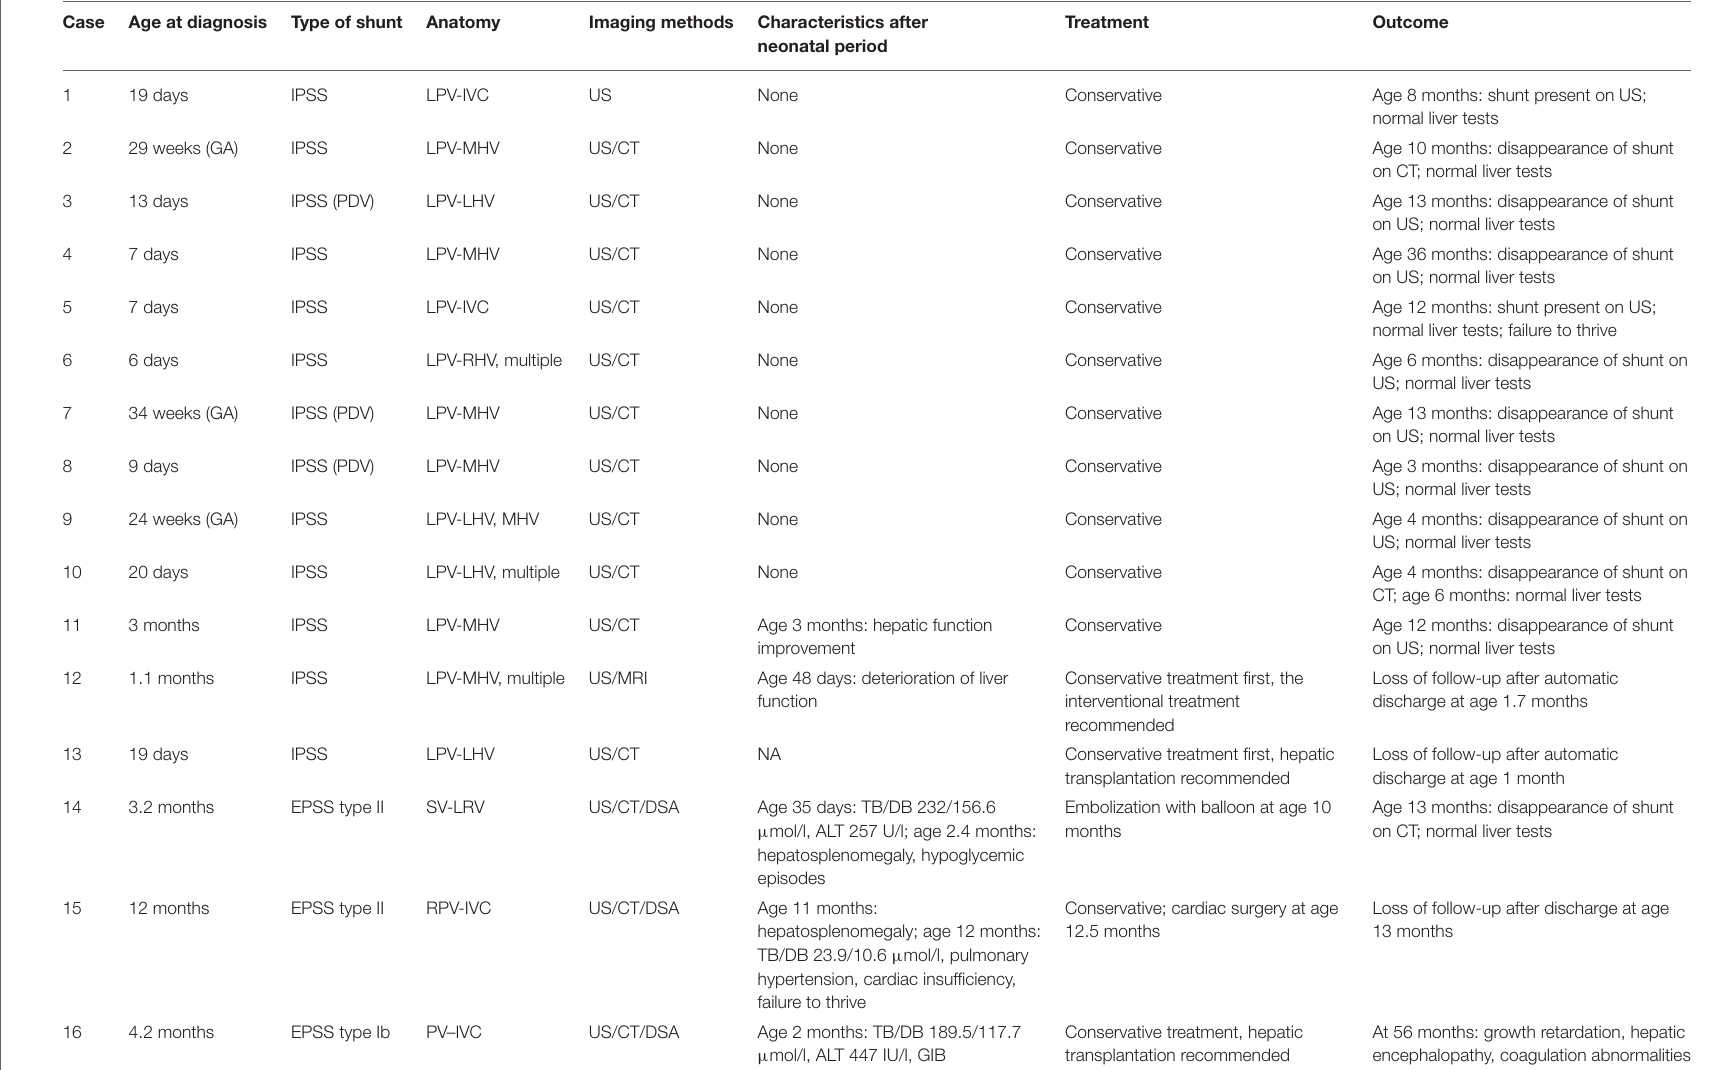
ALT, alanine aminotransferase; CPSS, congenital portosystemic shunts; CT, computerized tomography; DB, direct bilirubin; Dx, diagnosis; DSA, digital subtraction angiography; EPSS, extrahepatic portosystemic shunts; GA, gestational age; GIB, gastrointestinal bleeding; HPV, hepatic portal vein; IPSS, intrahepatic portosystemic shunts; IVC, inferior vena cava; PDV, patent ductus venosus; PV, portal vein; LPV, left portal vein; LHV, left hepatic vein; LRV, left renal vein; MHV, middle hepatic vein; MRI, magnetic resonance imaging; NA, not available; RPV, right portal vein; RHV, right hepatic vein; SV, splenic vein; TB, total bilirubin; UV, umbilical vein; US,